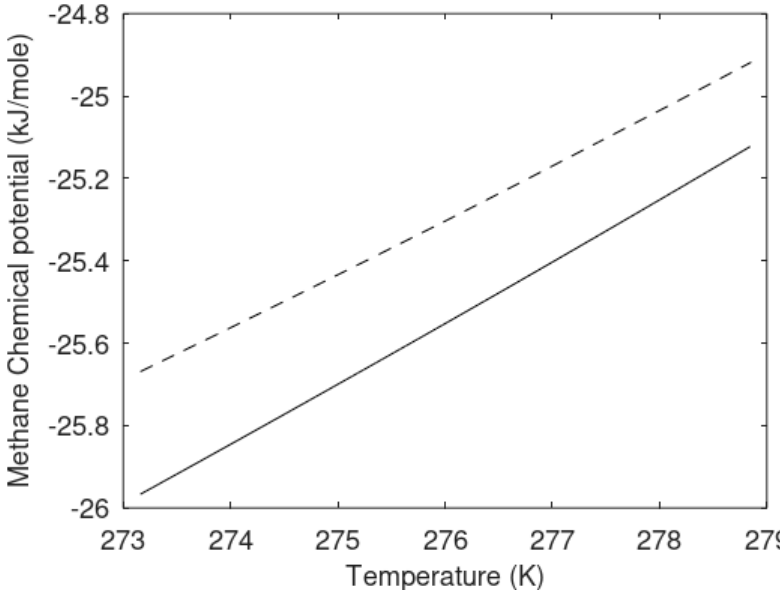
Figure 8. Chemical potential for methane in hydrate formed heterogeneously from water and CH 4 gas (solid) and chemical potential for methane in hydrate formed homogeneously from dissolved CH 4 in water (dashed).